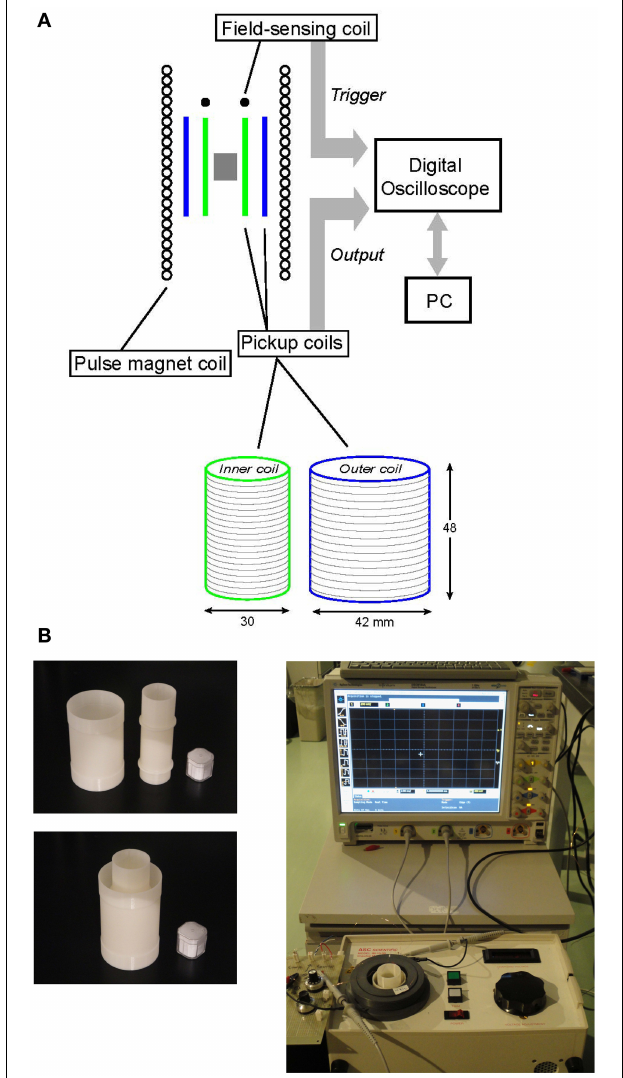
FIGURE 1 | (A) Schematic diagram of the measurement system. (B) (Left) Photos of the inner and outer pick-up coils (top) and the assembled system (bottom), with a 7-cc cube for scale. (Right) an overview of the measurement system. A field-sensing coil is placed at the bottom of the sample cavity of IM10-30 pulse